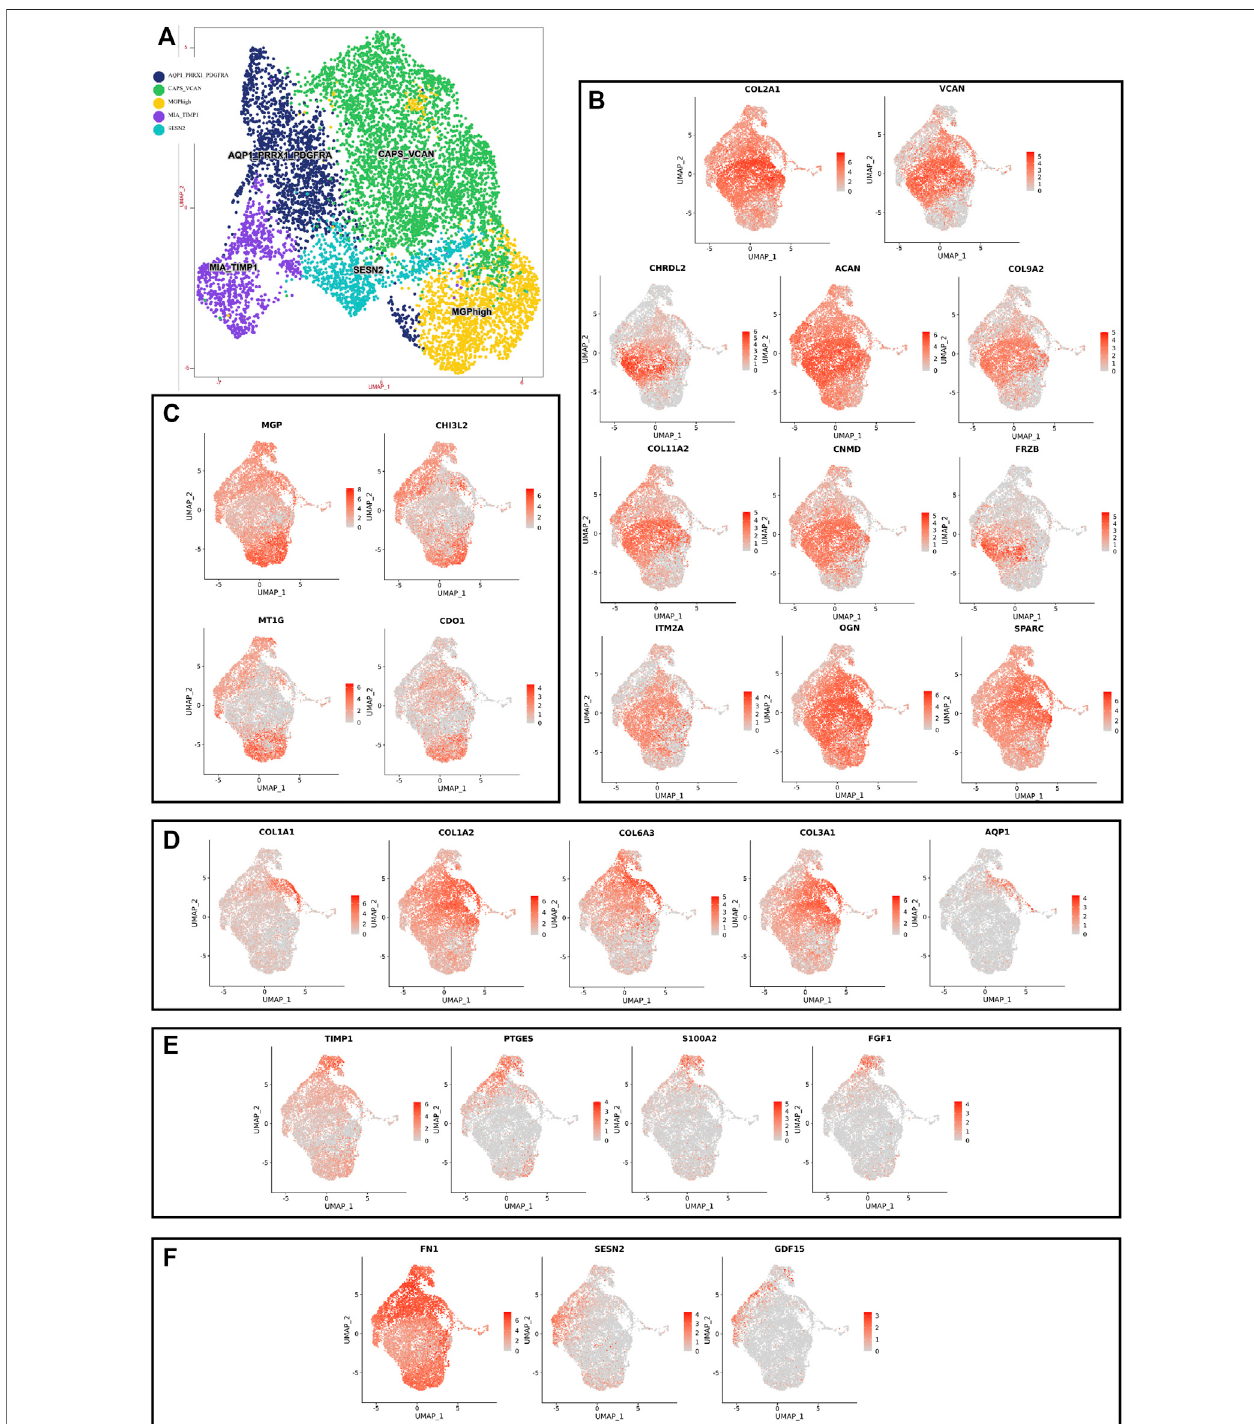
FIGURE 4 | scRNA-seq clustering marker gene analysis of nucleus pulposus cells. (A) UMAP plots show the expression of representative well-known markers across cell types in chondrocyte l of nucleus pulposus cells. (B) UMAP plot of chondrocyte 1 subtype, the expression level (up), and the AUC of the estimated regulon activity of these transcription factors (down). (C) UMAP plot of chondrocyte 2 subtype, the expression level (up), and the AUC of the estimated regulon activity of these transcriptionfactors(down). (D) UMAPplotofchondrocyte3subtype,theexpressionlevel(up),andtheAUCoftheestimatedregulonactivityofthesetranscription factors(down). (E) UMAPplotofchondrocyte4subtype,theexpressionlevel(up),andtheAUCoftheestimatedregulonactivityofthesetranscriptionfactors(down). (F) UMAP plot of chondrocyte 5 subtype, the expression level (up), and the AUC of the estimated regulon activity of these transcription factors (down).